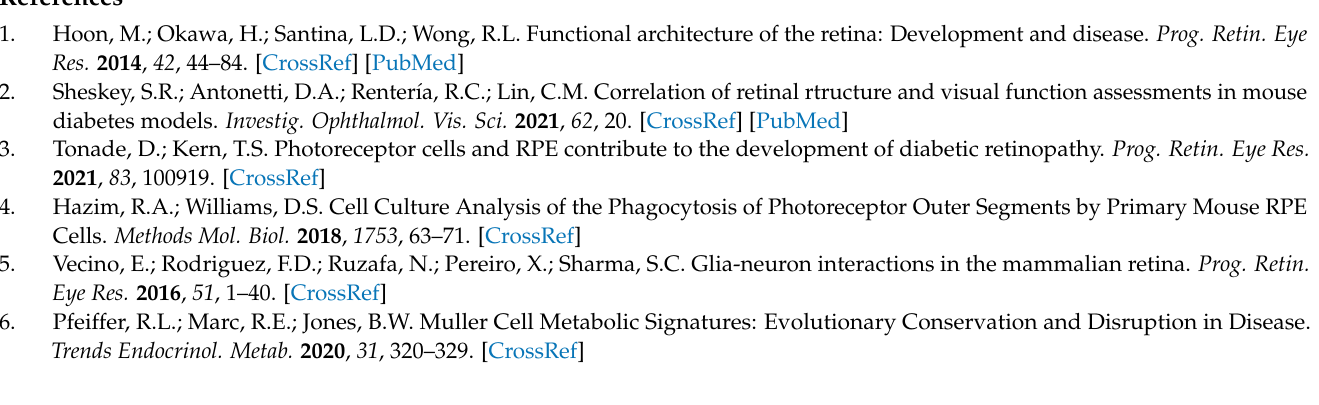
Figure S7: A potential combination drug therapy for redox stress-induced mitochondrial–lysosomal axis dysregulation and inflammasome activation in retinal diseases, Figure S8: HG increases TXNIP expression and reduces transcription factors TFEB and PGC1 α in